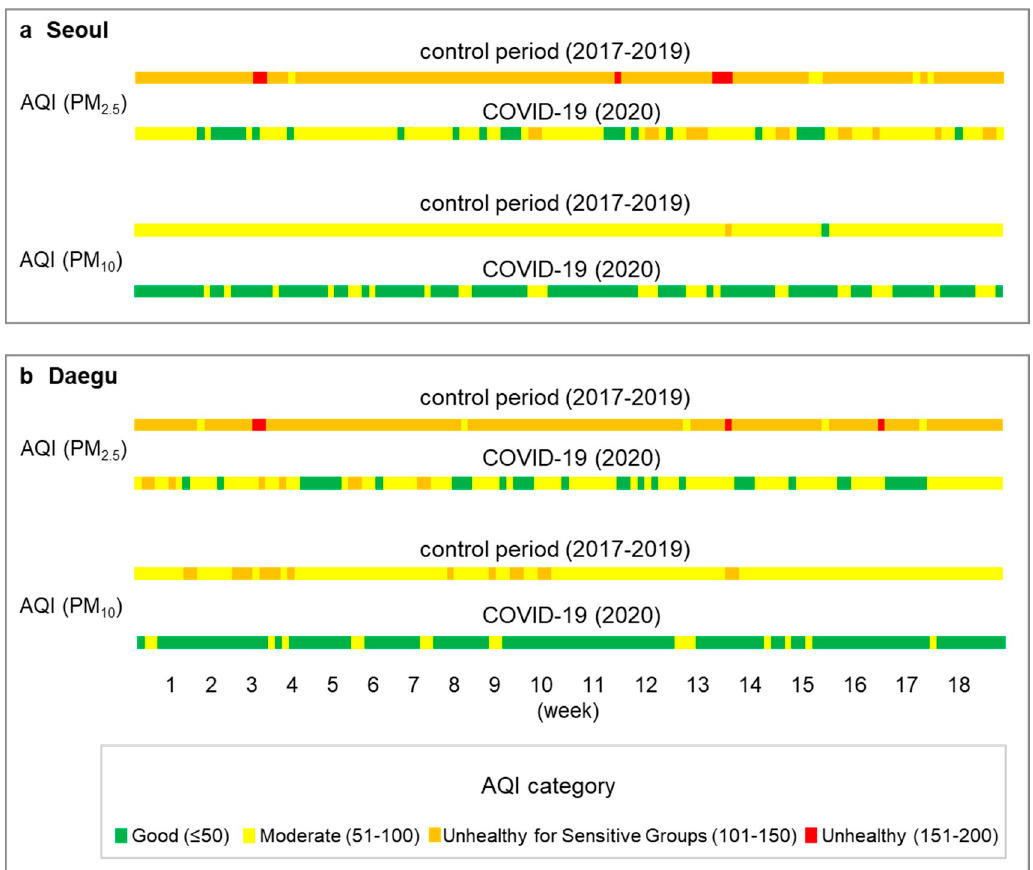
Figure 8. Comparison of daily AQI distribution of PM 2.5 and PM 10 . Each AQI color indicates a different level of health concern. (( a ): Seoul and ( b ): Daegu)